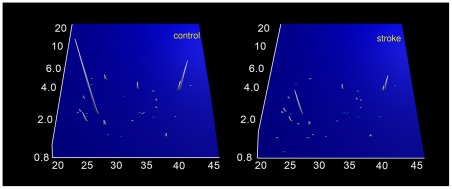
Polypeptide signatures of the 35 biomarker model in cases and controls.Normalized molecular weight (800–20 000 Da) in logarithmic scale is plotted against normalized migration time (18–45 minutes). The mean signal intensity of the polypeptide peak is given in 3-dimensional depiction. n = 26 controls and 33 cases.